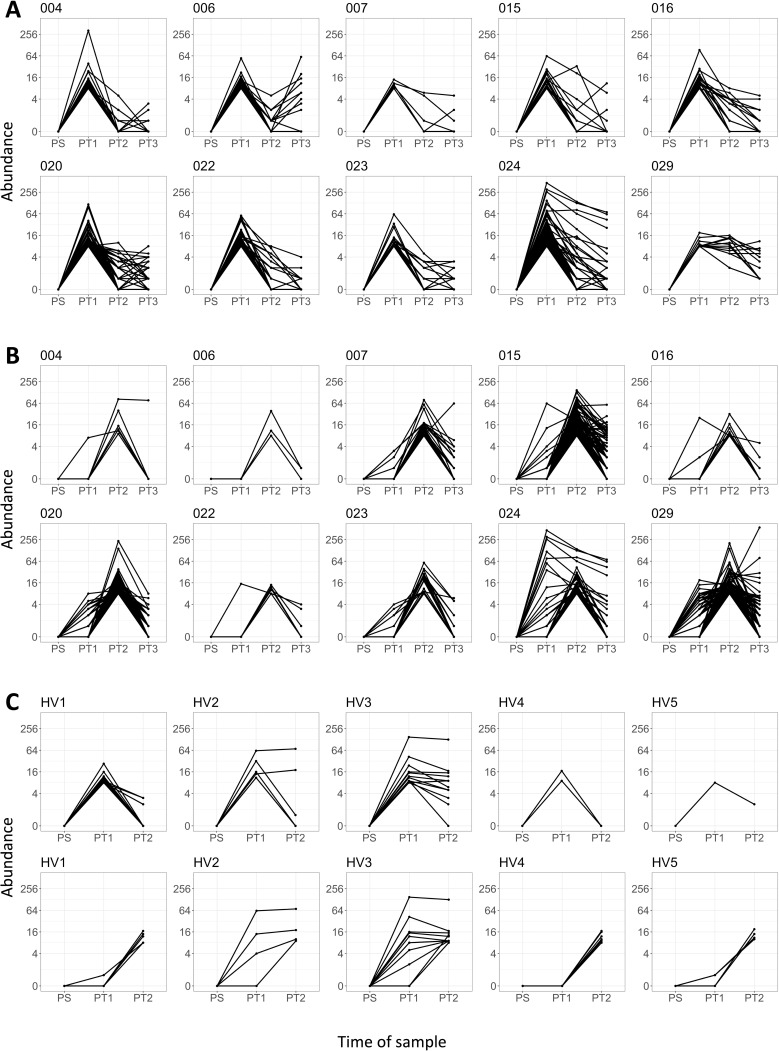
Dynamic changes in T cell receptor (TCR) frequency following sensitization.(A) The abundances of the PT1 expanded (threshold ≥8) beta TCRs at the four time points: PS, PT1, PT2, and PT3. Each panel is a different patient (n = 10). (B) The abundances of the PT2 expanded (threshold ≥8) beta TCRs at the four time points: PS, PT1, PT2, and PT3. Each panel is a different patient (n = 10). (C) Equivalent time points (0 weeks, 2 weeks, and 6 weeks) for five healthy volunteers. Top row is PT1 expanded beta TCRs; bottom row is PT2 expanded beta TCRs.